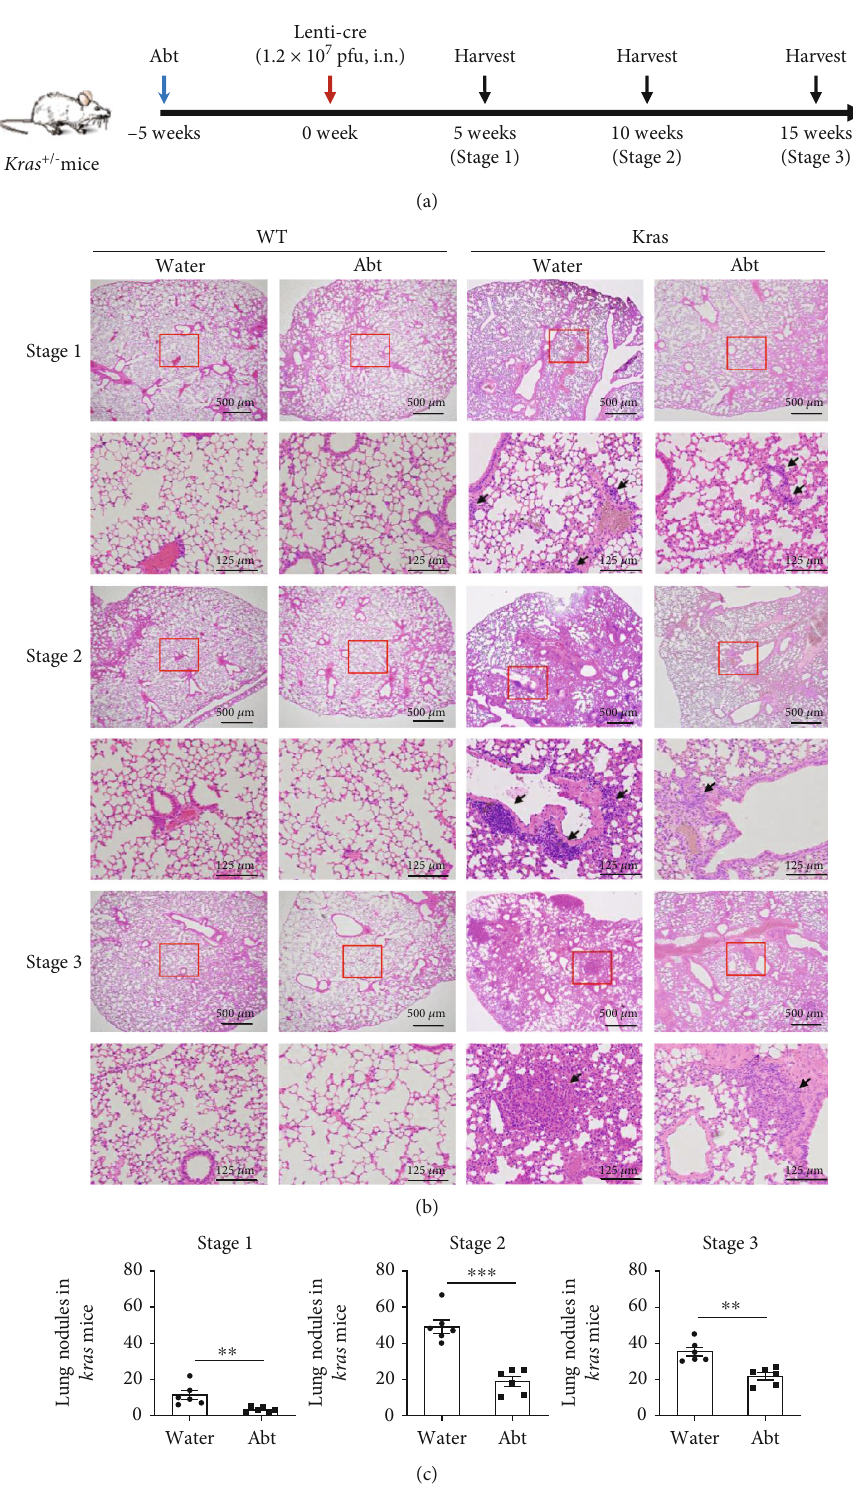
Figure 1: Progression of lung cancer was signi fi cantly inhibited in Abt- Kras mice. (a) Kras -mutated mice and paired control wild-type (WT) mice were infected intranasally (i.n.) with Lenti-Cre after being treated with combined antibiotics (Abt) in their drinking water for 5 weeks. The mice continued to receive Abt water throughout the experiments and tissues were harvested at 5 (stage 1), 10 (stage 2), and 15 (stage 3) weeks, respectively, after activation of the KRAS gene. Another two groups of Kras -mutated mice and WT mice were fed normal drinking water as controls. (b) Representative histology of the H&E-stained lungs of Kras mice and WT mice that receive Abt or normal drinking water at di ff erent stages of lung cancer. The number of tumour nodules in the two groups of Kras mice indicated in (b) is shown in (c). Each symbol in (c) represents an individual mouse; n = 6 . Data are presented as mean ± SEM . ∗∗ p < 0 : 01 and ∗∗∗ p < 0 : 001